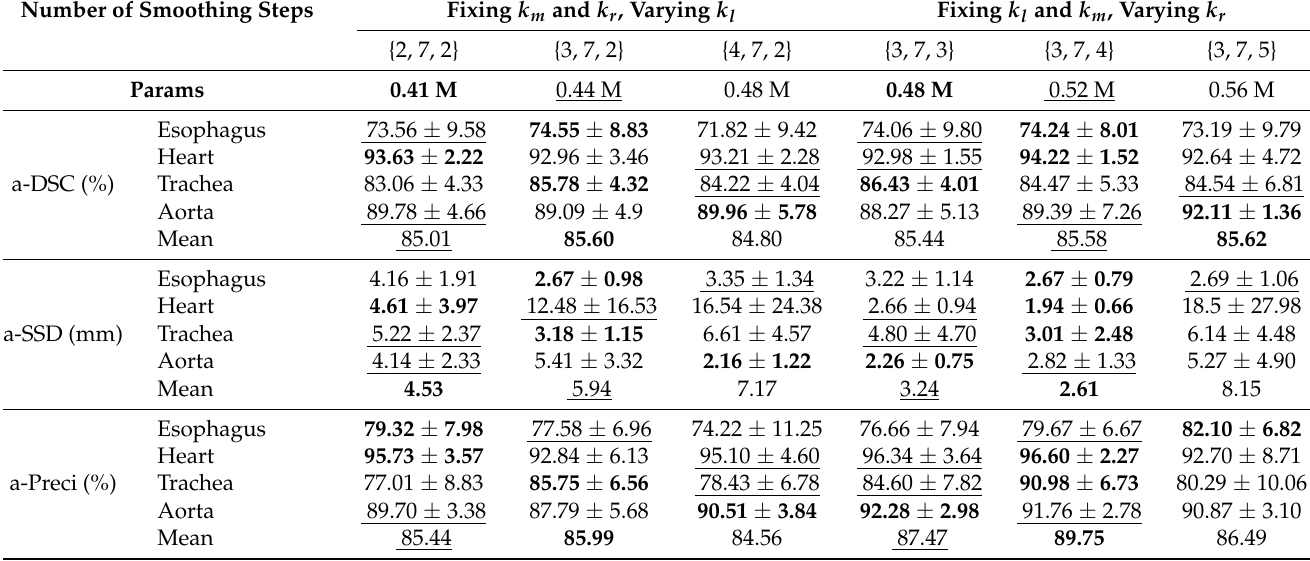
Table 2. Quantitative assessment with the a-DSC, a-SSD, and a-Preci values of different pre-/coarest- /post- smoothing iteration numbers { k l , k m , k r } using the proposed 2D FAS-UNet framework on the 2D SegTHOR validation datasets with four organs: esophagus, heart, trachea, and aorta. “Mean” denotes an average score segmenting all organs. The best and second places are highlighted in bold font and underline,